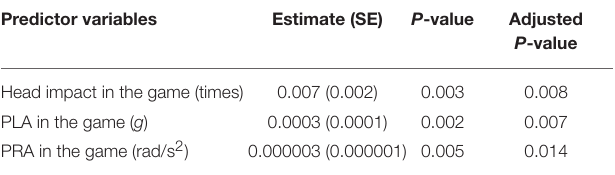
TABLE 2 | Association of acute S100B increase (post minus pre game: unit in µ g/L) with head impact kinematics. Predictor variables